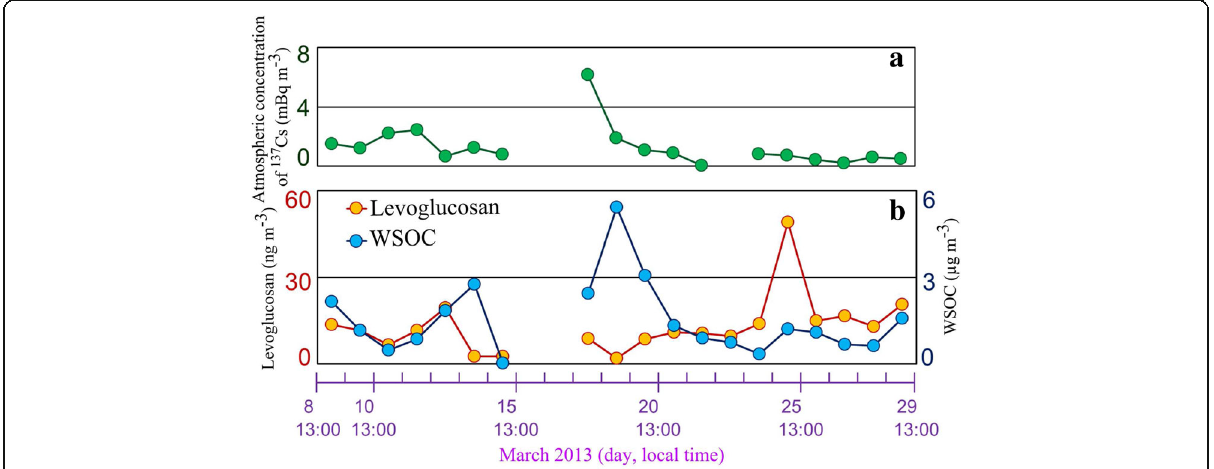
Fig. 8 Time series of a the radiocesium concentrations and b the concentrations of levoglucosan and WSOC in the atmosphere at